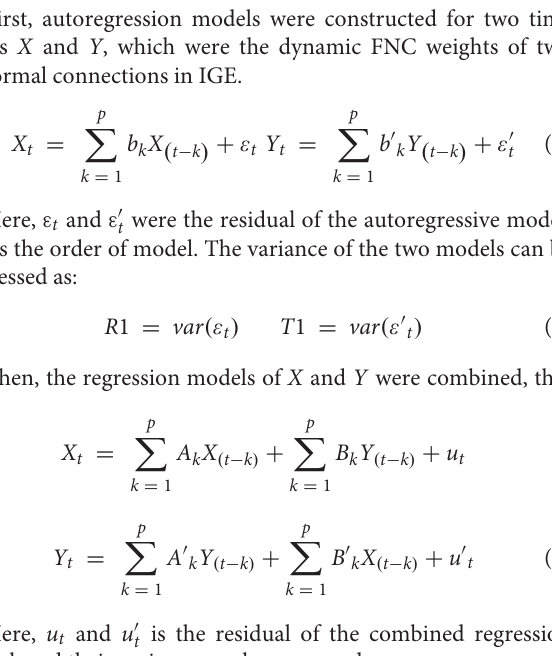
Table 1 . Then, the temporal coursed was band-pass filtered (0.01– 0.1